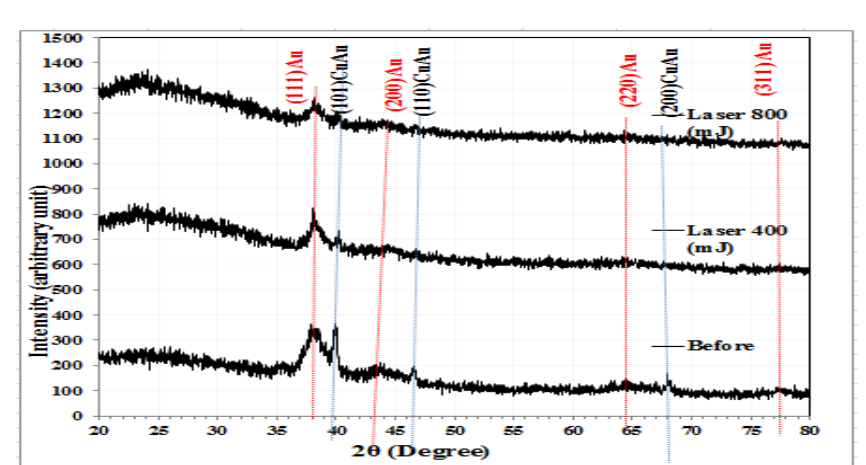
Fig. 6: X-ray diffraction pattern of A-alloy colloid NPs for exploding currents 100A and synthesized by (400 m J, 800 m J) laser energies